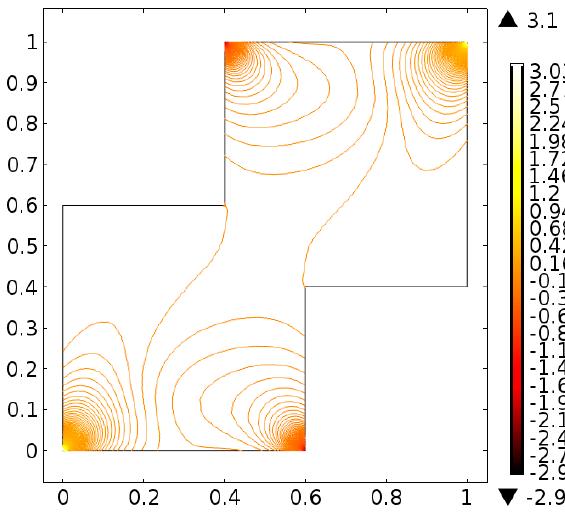
Figure 36. Pressure distribution at Re = 100 for case-III.